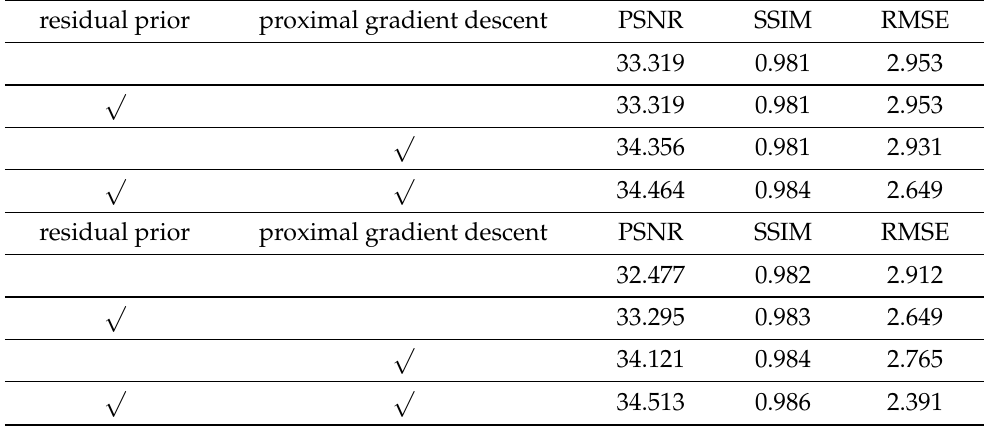
Table 5. Ablation study of UIR-Net on the MSRB and MSIRB datasets.